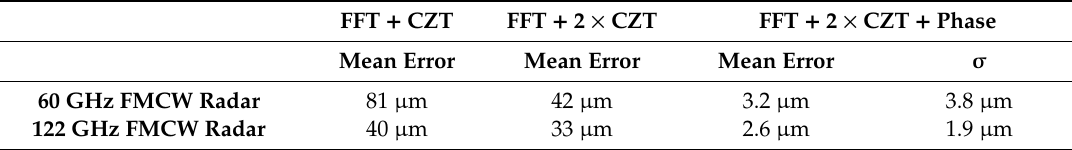
Table 2. Measurement summary of the 60 GHz and 122 GHz FMCW